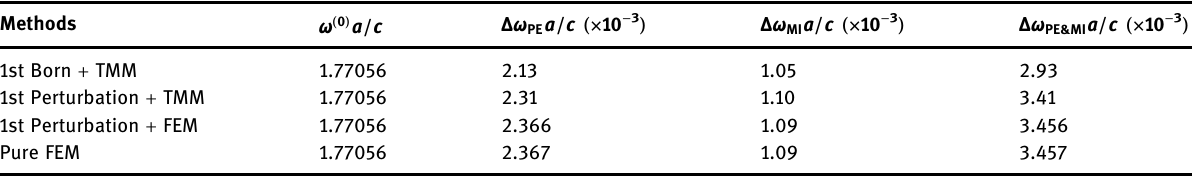
Table 2: Normalized frequency shift of optical mode ω 2 is continuously perturbed by the acoustic wave at the resonance frequency Ω a c